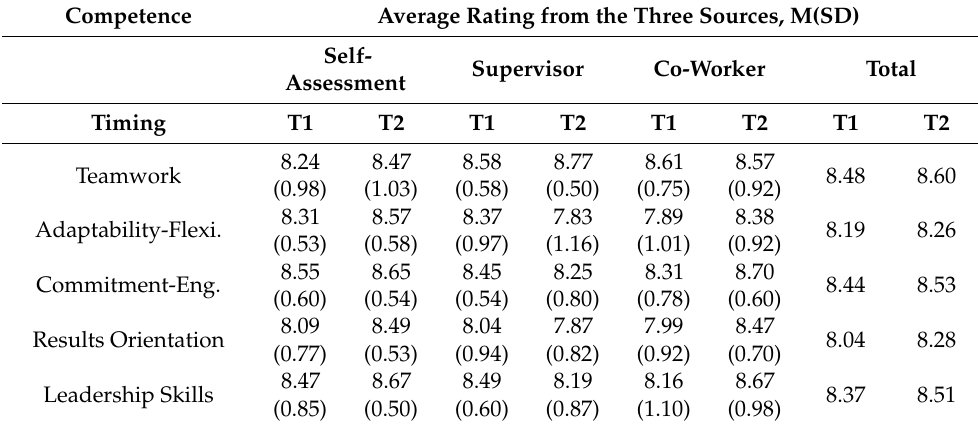
Table 4. Ratings of competencies by time point and sources for staff subsample. Competence Average Rating from the Three Sources, M(SD) Self- Supervisor Assessment